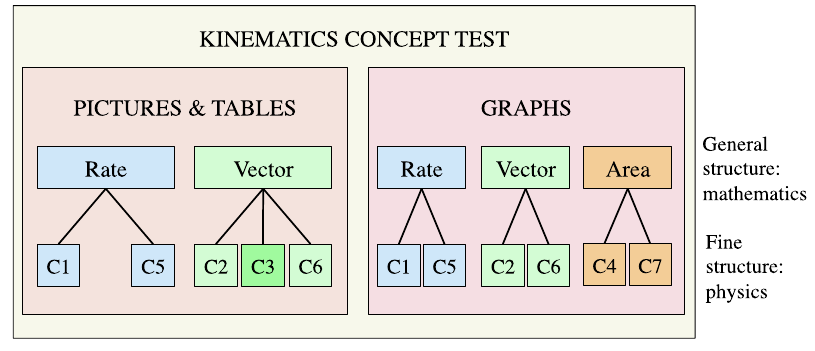
FIG. 5. Structure of the kinematics concept